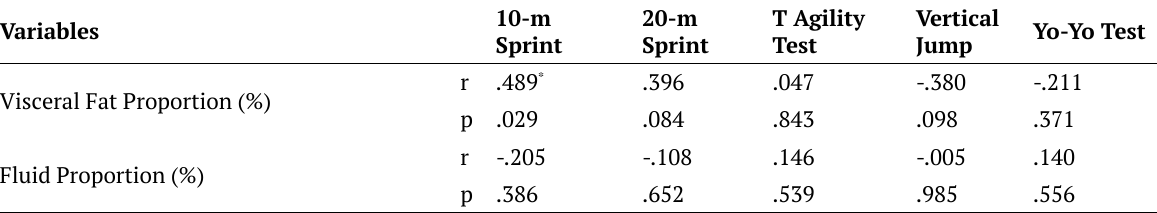
Table 4. Spearman Correlation Test Results for Body Composition and Biomotor Tests